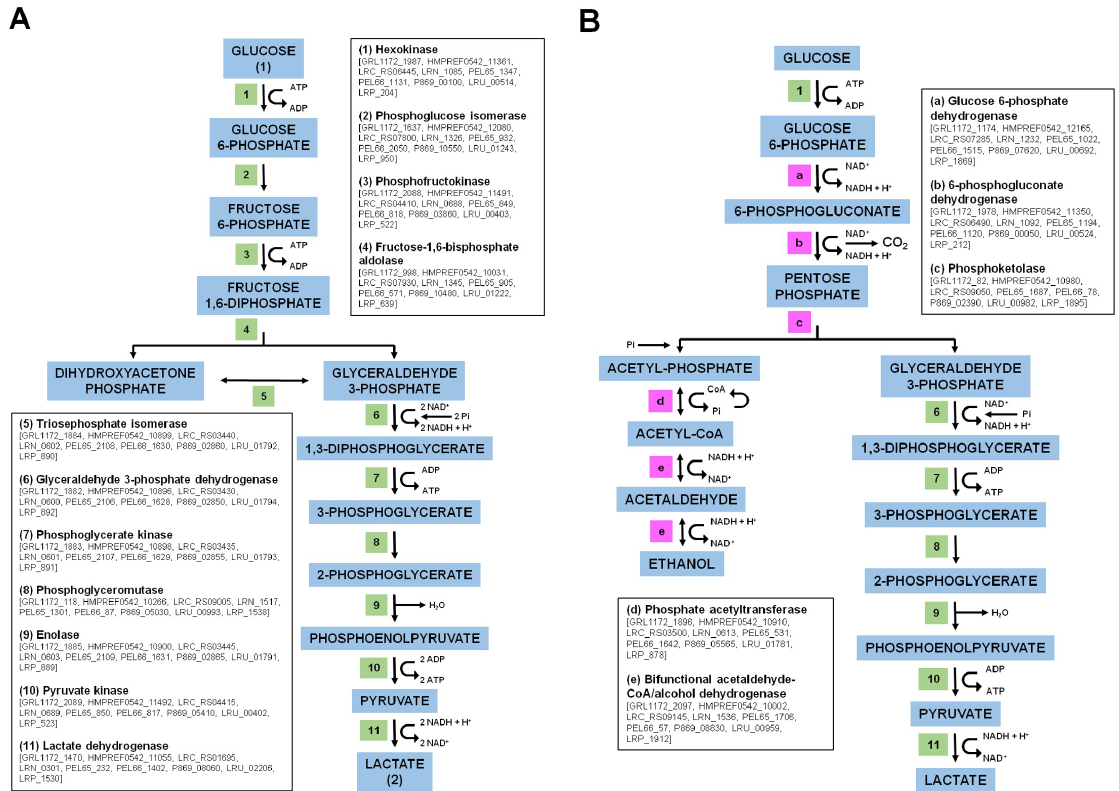
Fig 5. Schematic outline of the putative homolactic and heterolactic fermentative pathways in L . ruminis . Depictedis the glycolytic metabolismthat can occur duringhomolacticfermentation via the Embden-Meyerhof-Parnas (EMP) pathway (A) or heterolacticfermentation via the phosphoketolasepathway (PK) (B) . Included are the variouspathway reactions with their precursor metabolites and enzymes. Shownin the insets are the names of the glycolyticenzymes, either numbered(1–11) or alphabetized (a-e) along with the locus tags of their putative genesin the nine L . ruminis genomes.Enzymes that overlap in both pathways are numbered similarly.